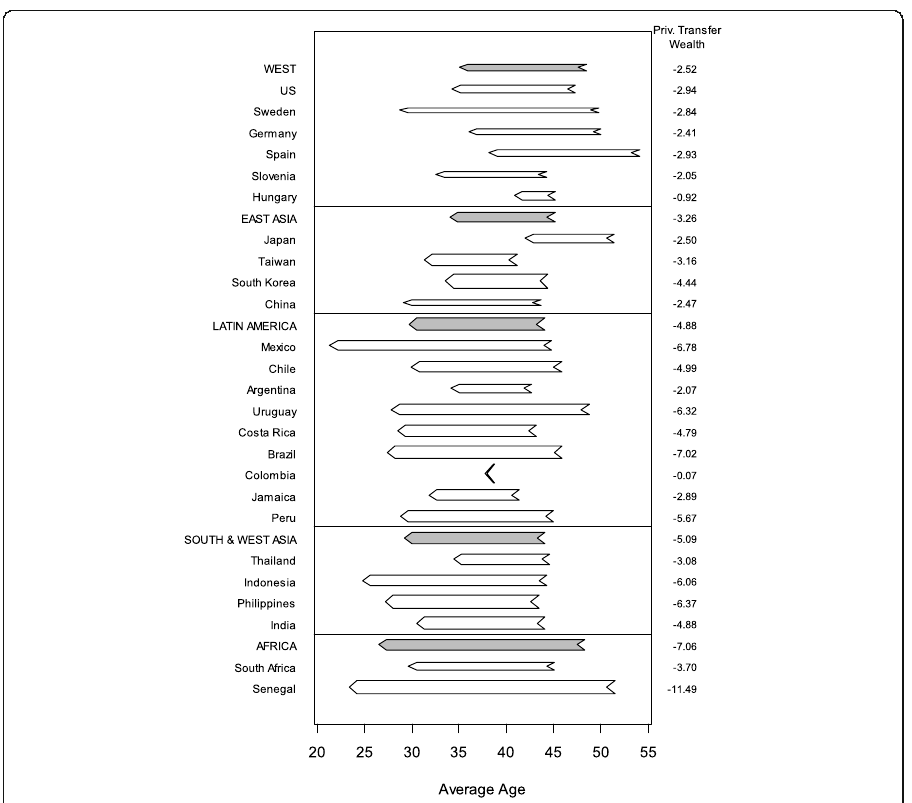
Fig. 5 The direction and magnitude of private transfer flows. Note: Head of arrows is average age of receiving transfer, and tail is average age of giving transfer. Countries ranked within region by per capita GDP (ppp-adjusted, US$) in 2005. Regional averages are unweighted. Regions ranked by per capita GDP. Source: National Transfer Accounts data. For data, see ntaccounts.org. Average age and per capita calculations use United Nations Population Division (2013) population data for year of NTA age